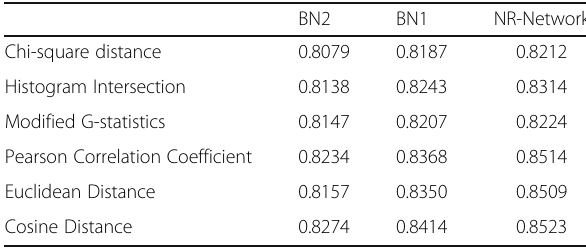
Table 2 The average recognition rates of the networks using different distance measures on the AR database BN2 BN1 NR-Network Chi-square